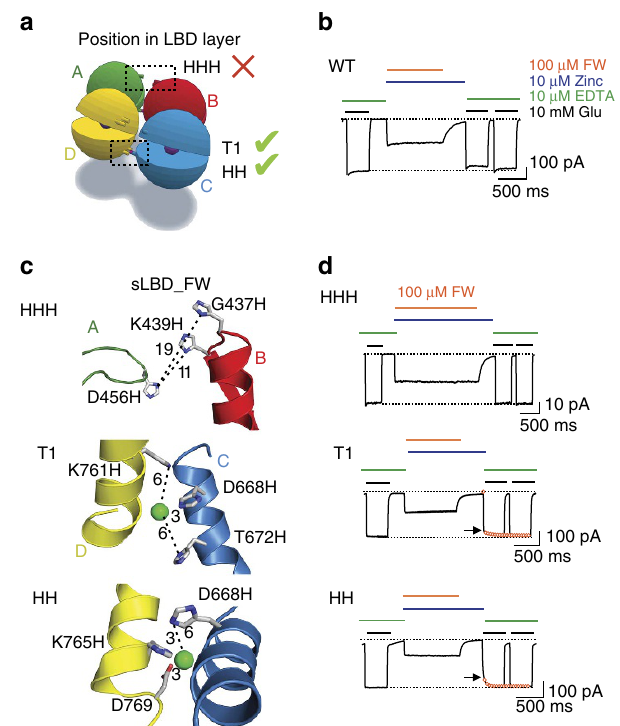
Figure 4 | Failure to trap the D1 lateral interface is particular to saturating FW. ( a ) Cartoon showing the localization of the mutants in the LBD layer. The red cross indicates that the HHH mutant is expected not to trap with FW, whereas the green ticks indicate proximity consistent with trapping. ( b ) Wild-type receptors did not show a decrease in the active fraction after the application of Zn 2 þ and FW. ( c ) The mutated residues are depicted in the sLBD_FW structure. Expected distances between the histidine imidazole N-atoms and fictive Zn 2 þ ions (green spheres) are denoted by dotted lines and expressed in Ångstroms. ( d ) Patch-clamp experiment showing the response of the HHH mutant, which was not modified in saturating FW. The difference between the active fraction after trapping in the presence of FW versus WTwas not significant ( P ¼ 0.5436). The difference between the active fractions after the trapping of T1 and HH was induced by FWcompared with WTwas significant ( P o 0.009). Arrows indicate the reduction of the current after trapping. The recovery of current in 10mM glutamate and EDTA following trapping (fit with double exponential function, circles) showed a common fast component, corresponding to the exchange of solution, and a